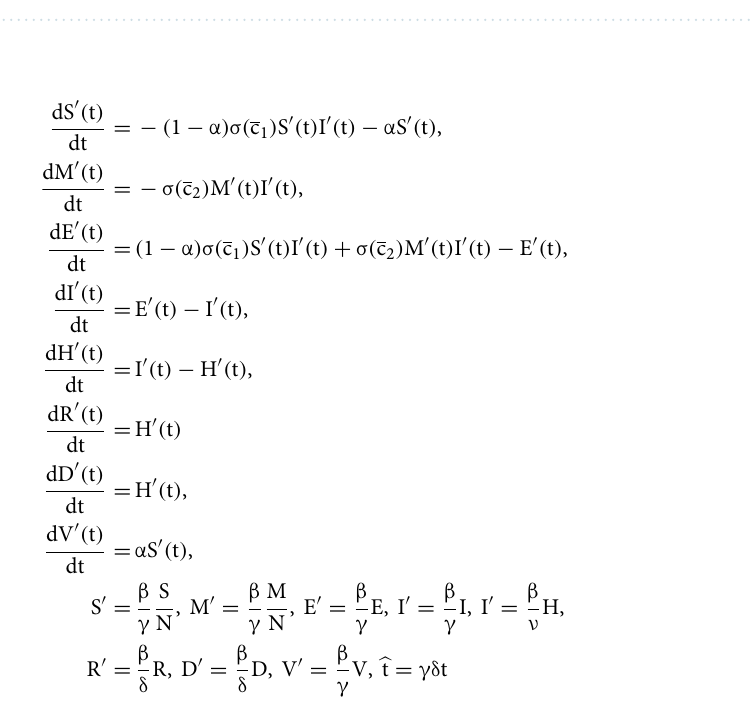
Table 1. Description of